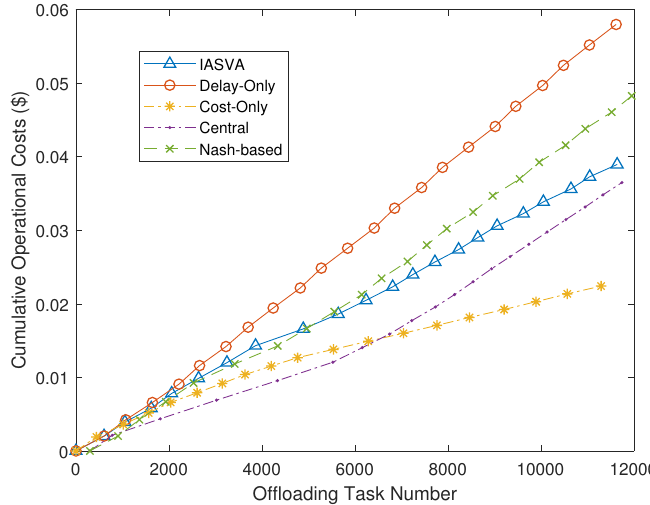
Figure 3. Cumulative operational costs of five